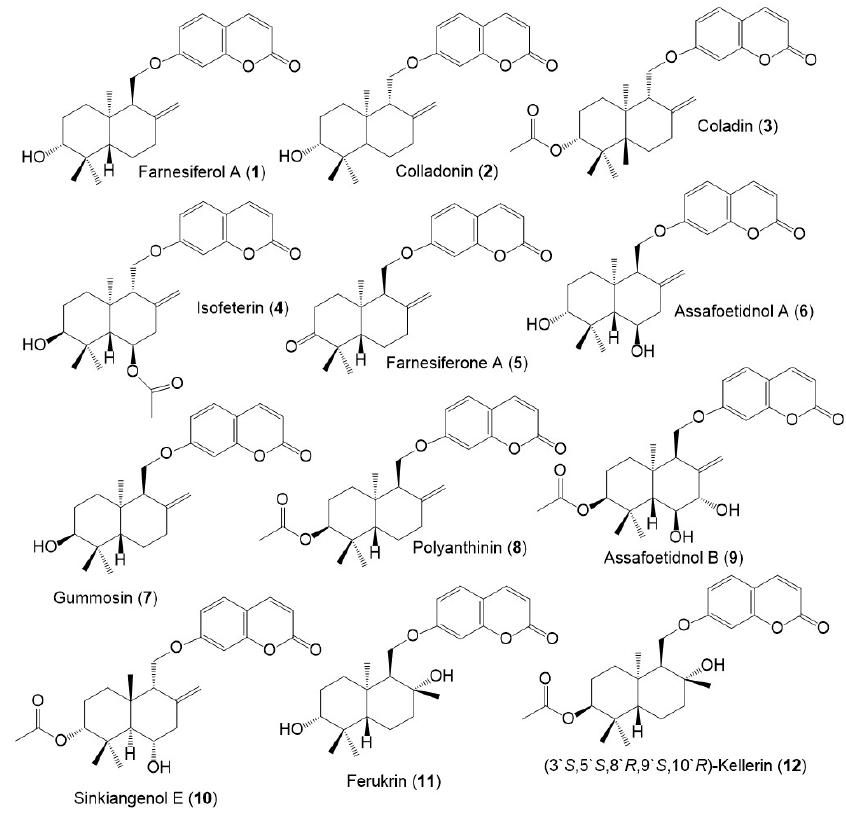
Figure 3. Structures of sesquiterpene coumarins ( 1 – 12 ) reported from F. sinkiangensis .